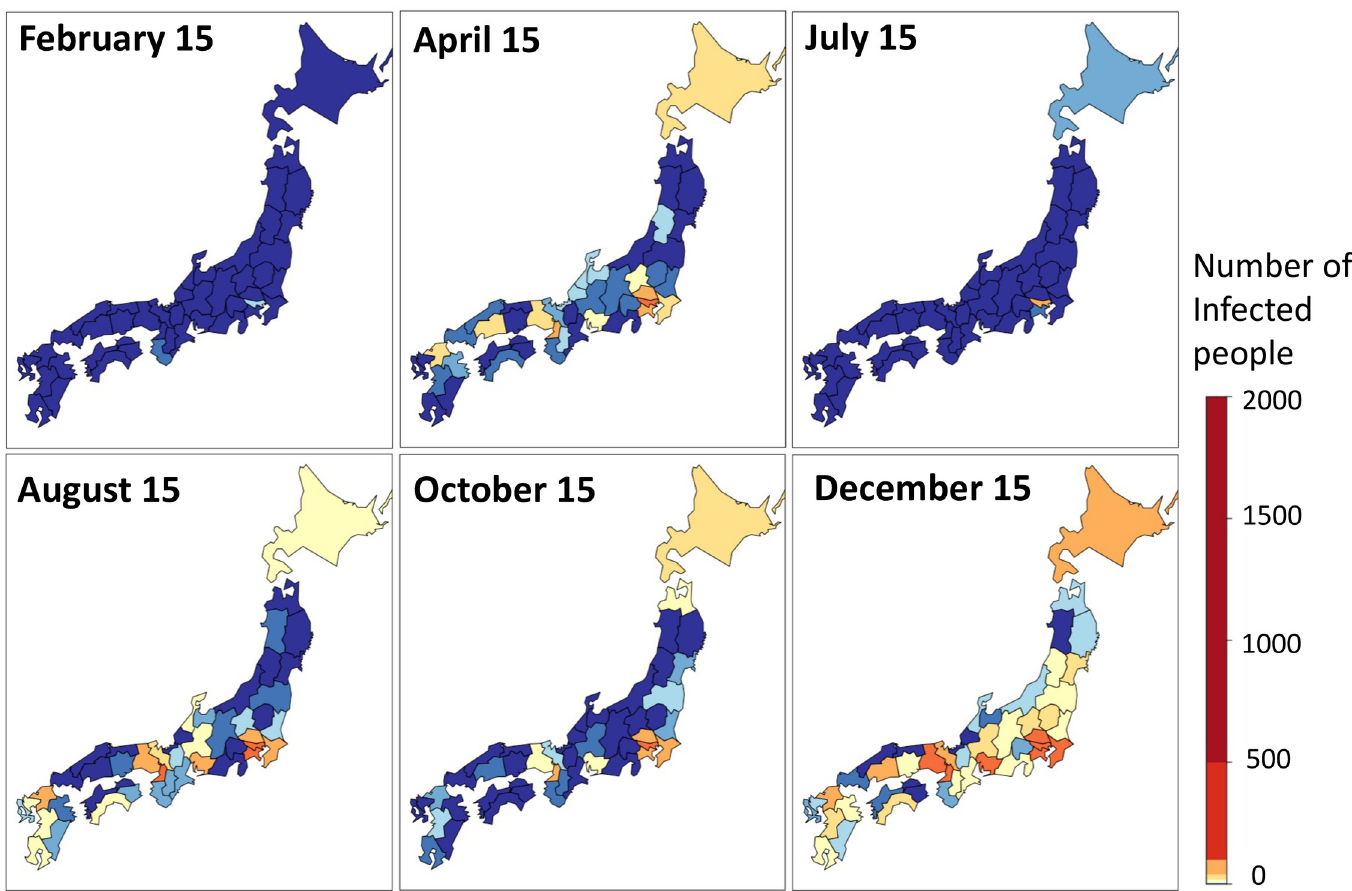
Fig 14. Number of cases by prefecture.